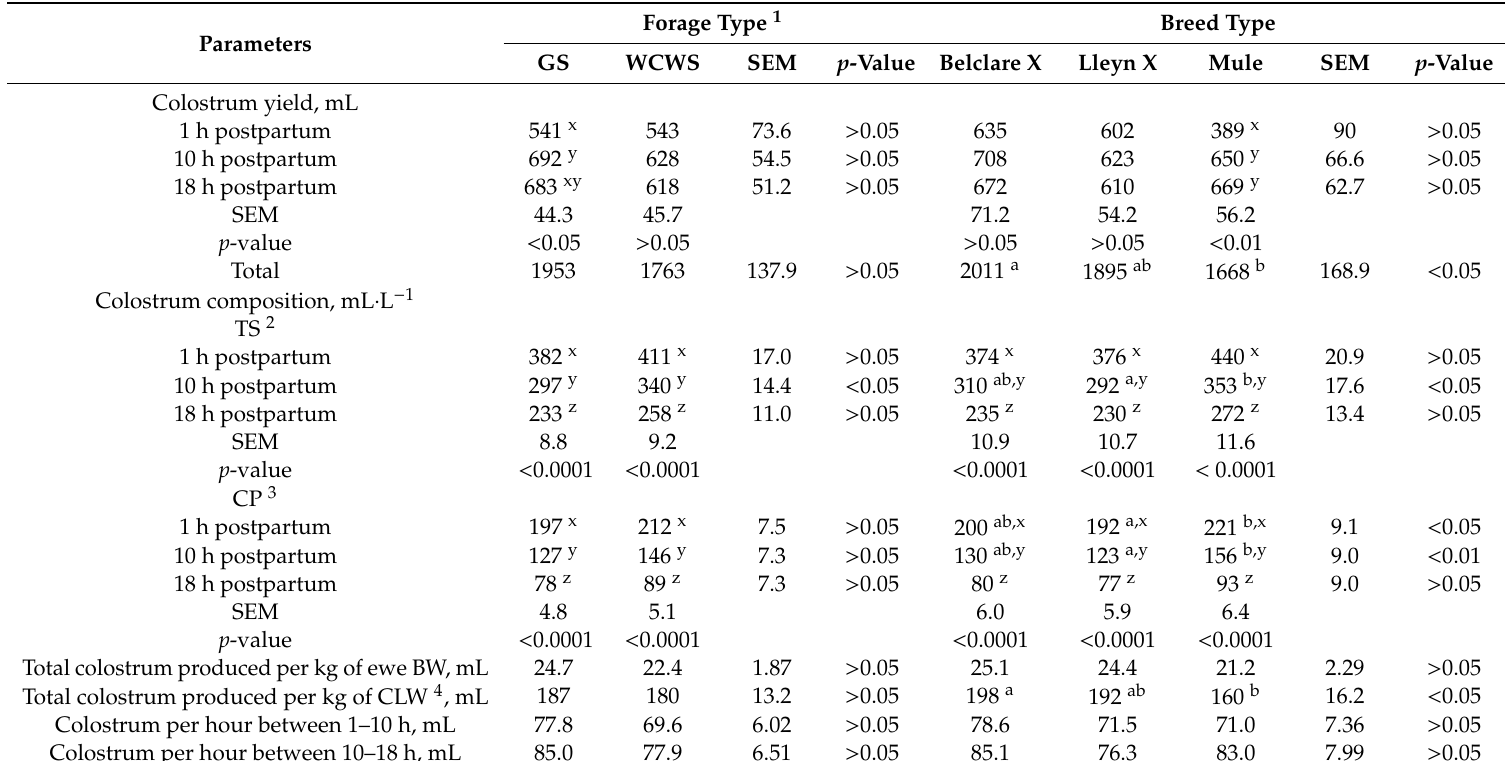
Table 5. The e ff ect of forage type and breed type on colostrum yield and composition (least square means ± SEM).